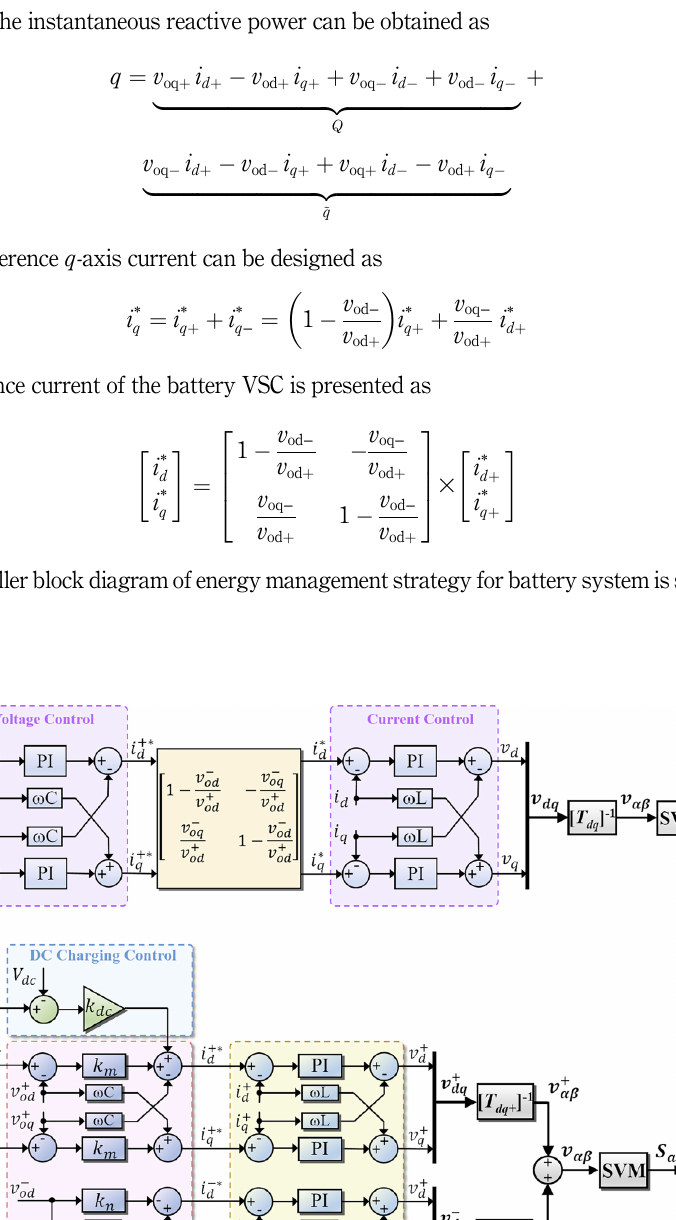
Figure 3. Control block diagram of HESS for (a) battery and (b)